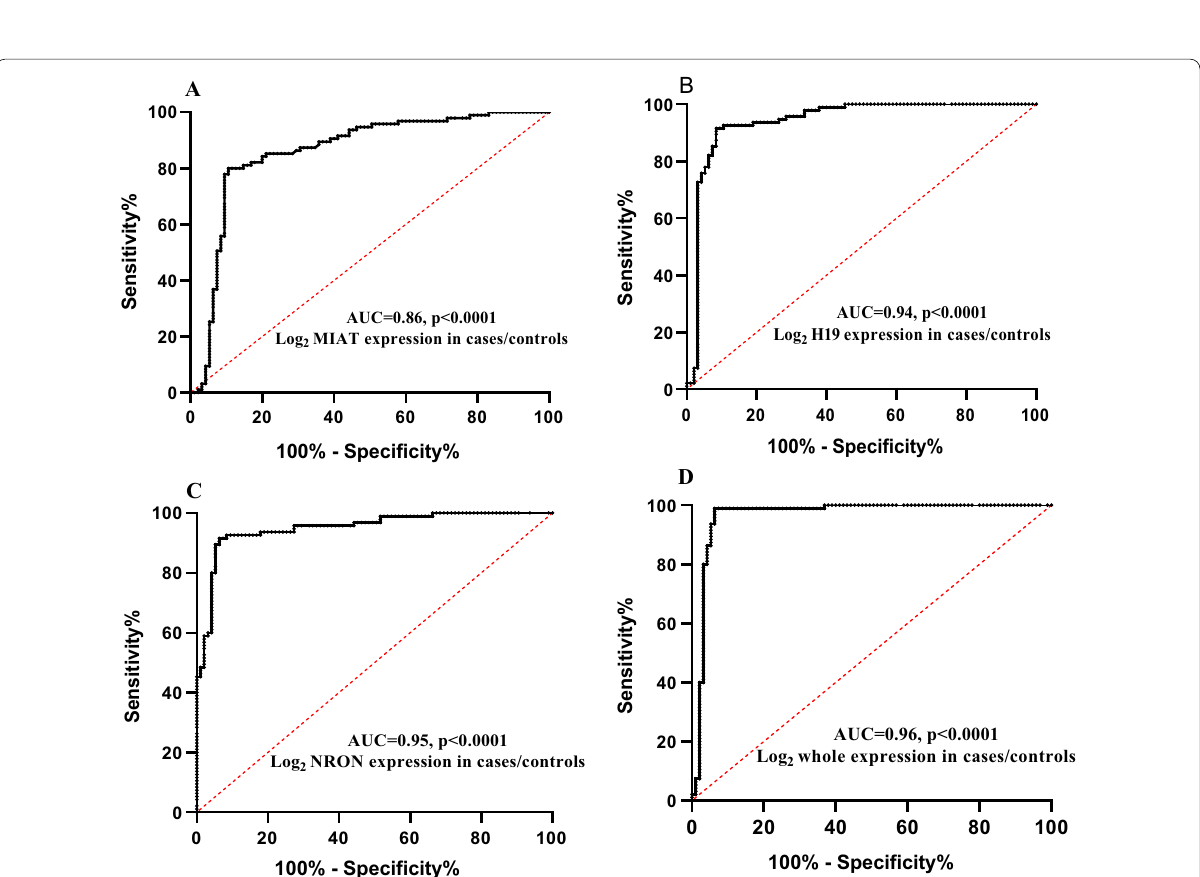
Fig. 2 ROC curves. A ROC curve analysis of MIAT for diagnosis MS patients from the controls, B ROC curve analysis of H19 for diagnosis MS patients from the controls, C ROC curve analysis of NRON for diagnosis MS patients from the controls, D ROC curve analysis of whole expression for diagnosis MS patients from the